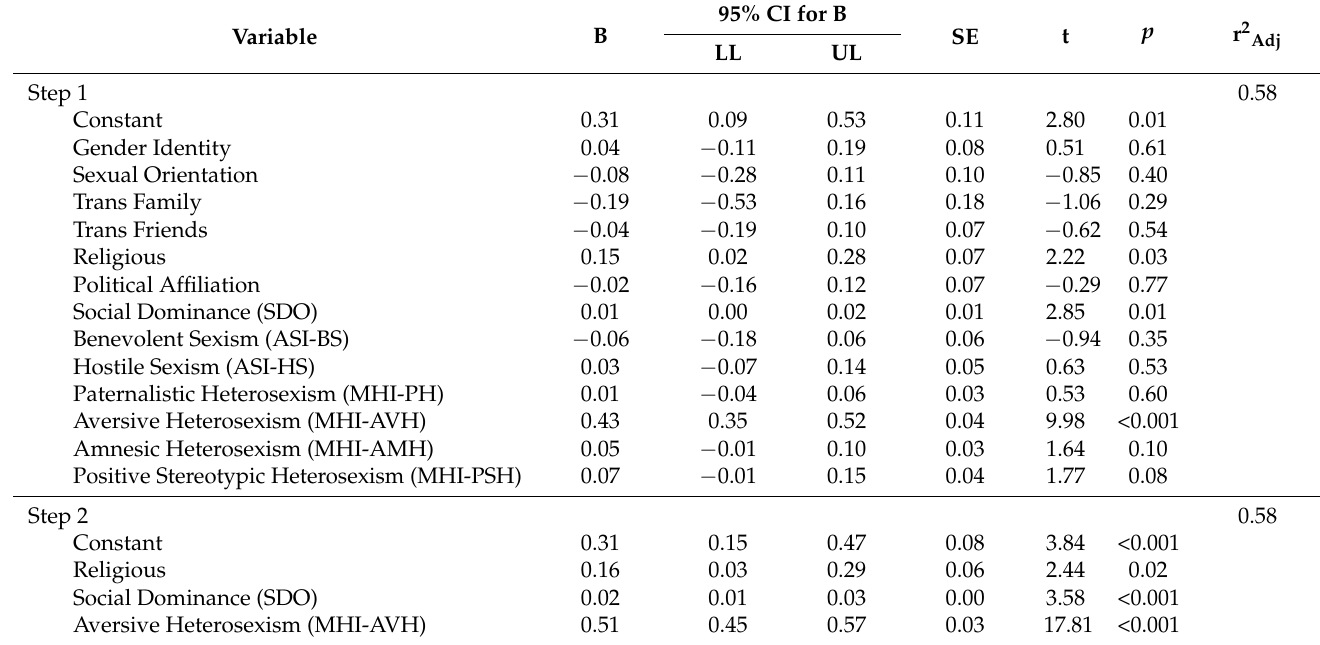
Table 5. Regression Coefficients for